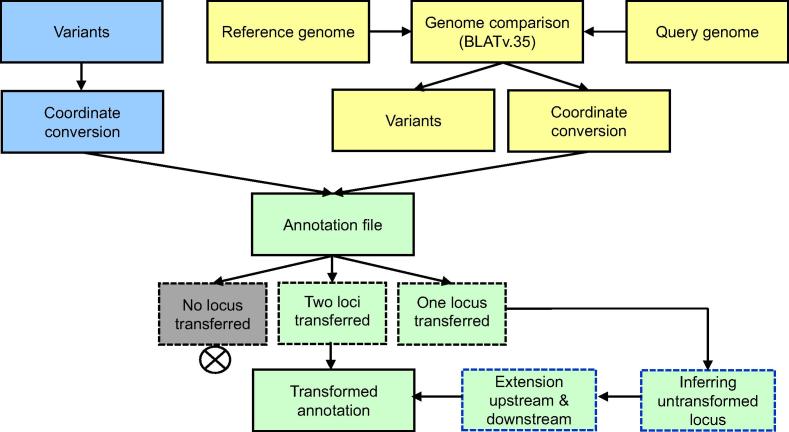
Workflow of annotation transferThe annotation transfer pipeline integrates two sets of information: the transfer progress based on variant identification (blue), and the transfer progress based on genome comparison (yellow). The integrated annotation file is classified into three categories (dashed borders in black): no locus transferred, two loci transferred, and one locus transferred. Annotation file in the first category is discarded, while file in the second one is transferred directly and file in the third one needs two extra steps (dashed borders in blue) to infer untransformed locus by extension to both upstream and downstream regions.